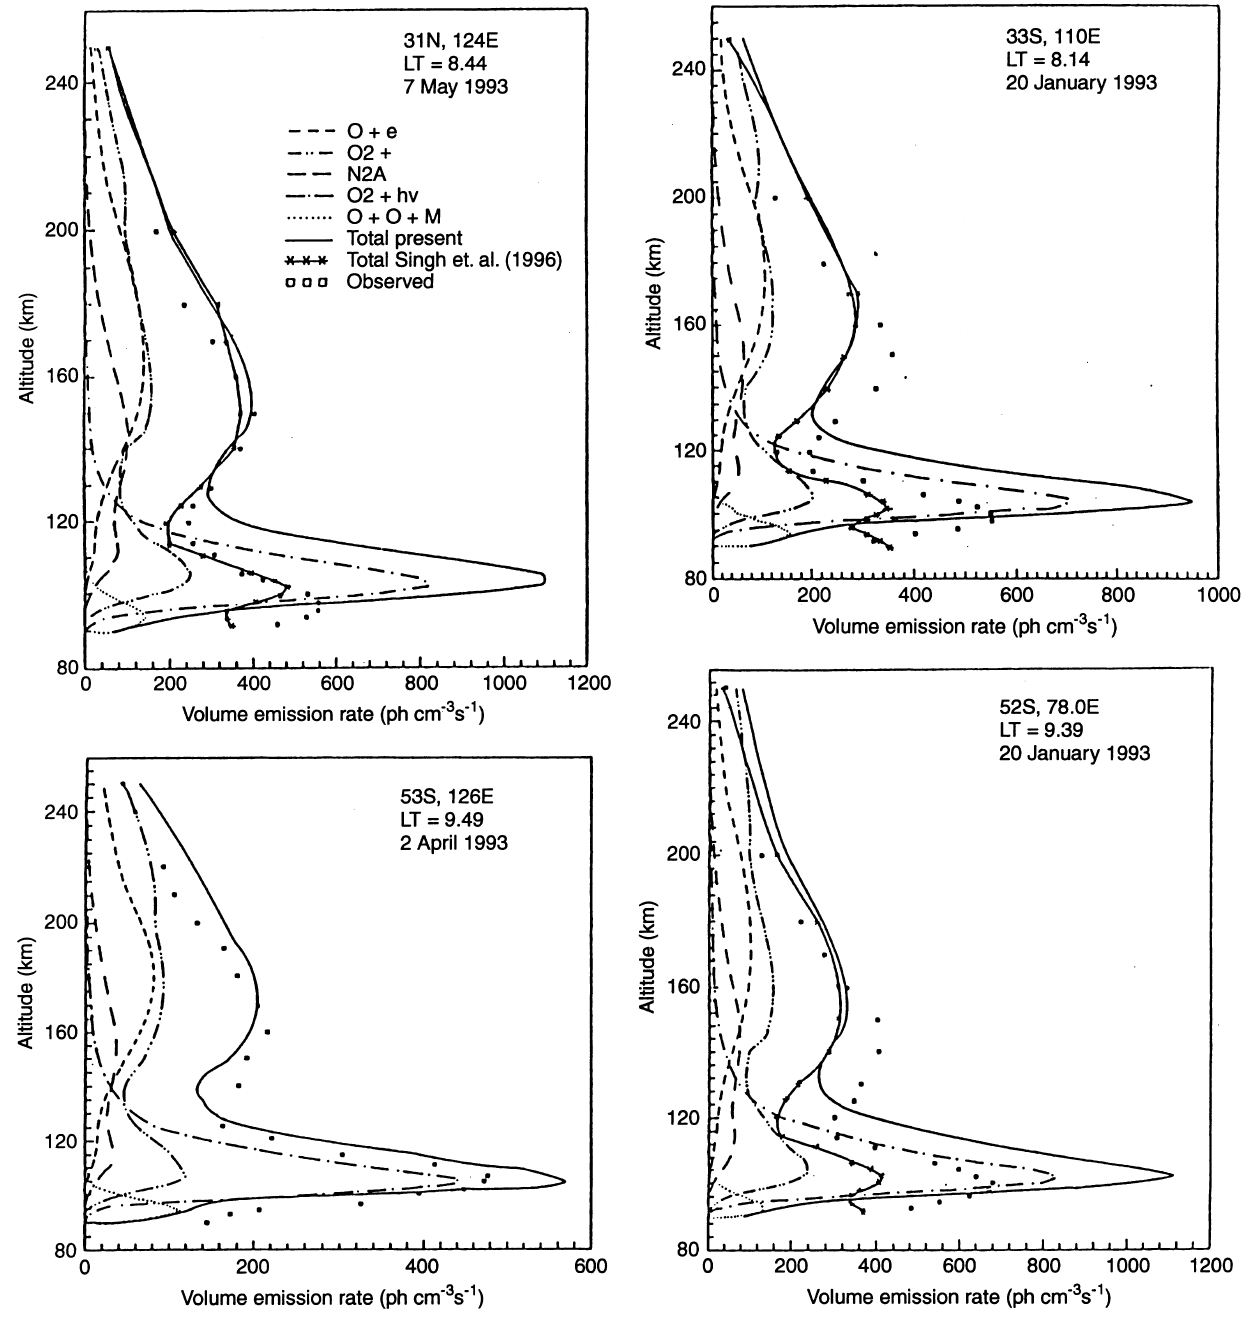
Fig. 1. Modelled and measured greenline dayglow emission profiles for selected observing (WINDII) conditions alongwith the various contributions of O( 1 S)